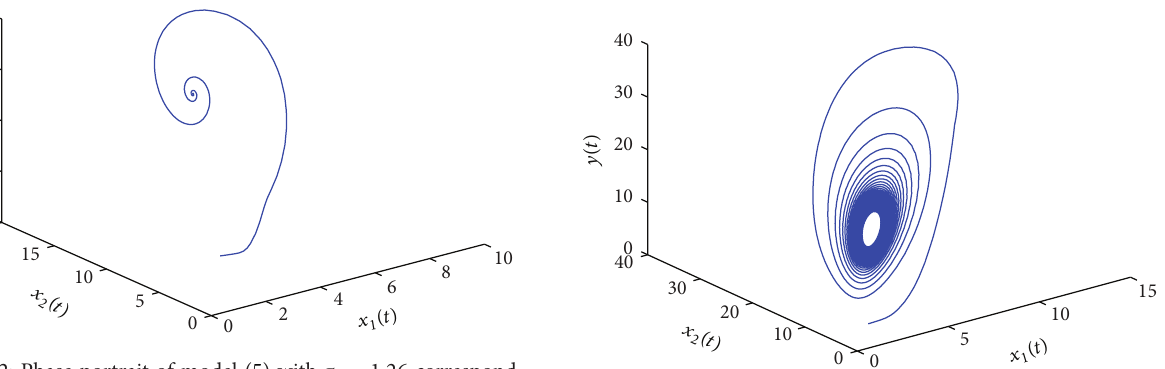
Figure 3: Dynamical responses of model (5) with 𝜏 = 2.5 , which shows that model (5) is unstable around the interior equilibrium and stable periodic solutions bifurcate from the interior equilibrium (5.058, 14.932, 11.395) .